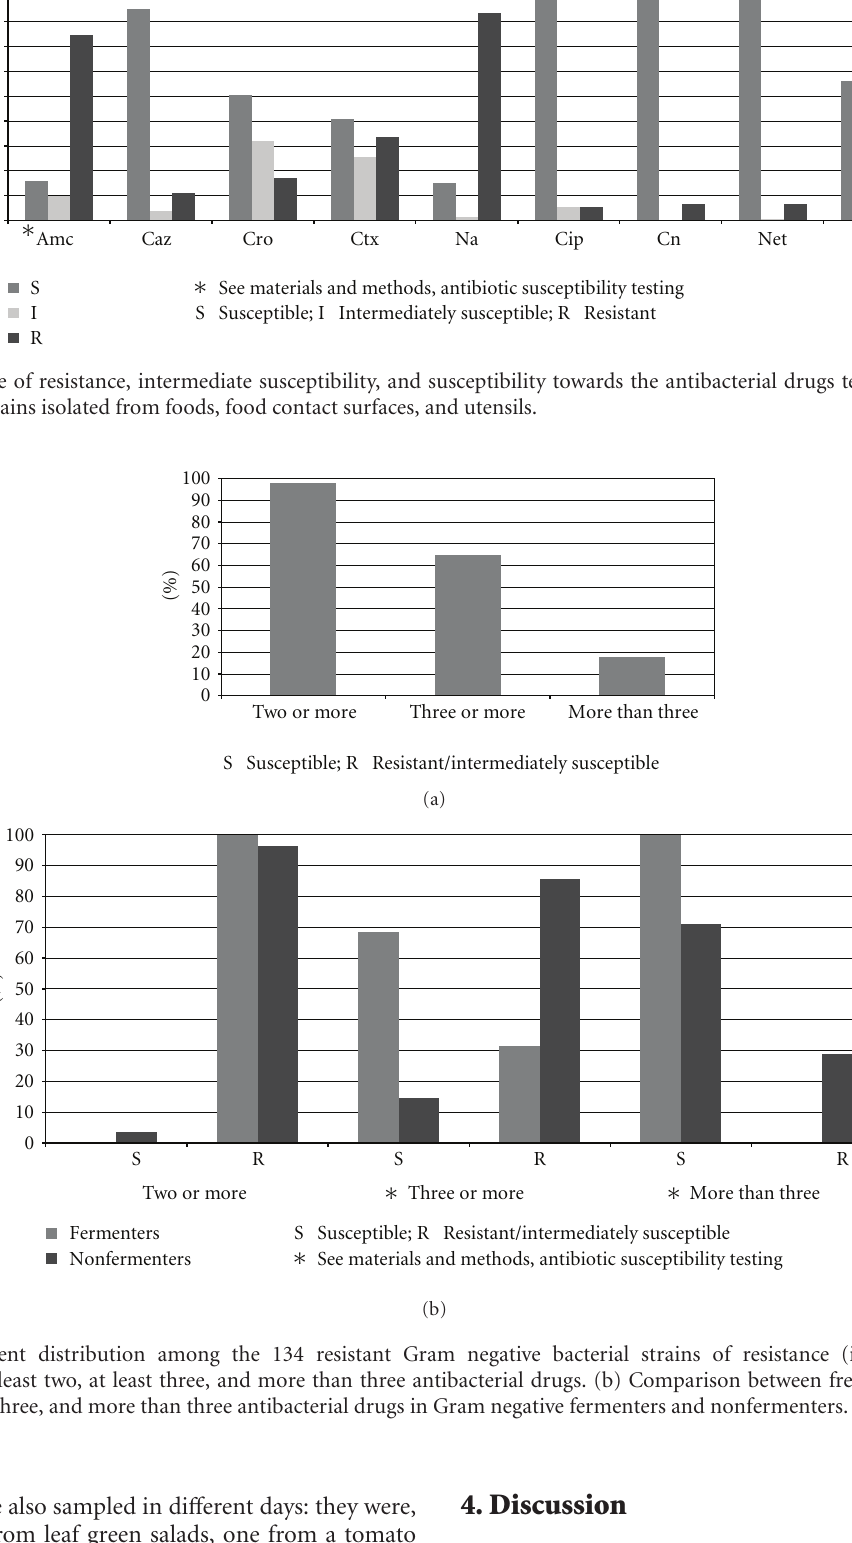
pattern NF28 were also sampled in di ff erent days: they were, respectively, five from leaf green salads, one from a tomato salad, and one from a soft cheese based dish. The interval of time between the first and the last isolation was in both case of 50